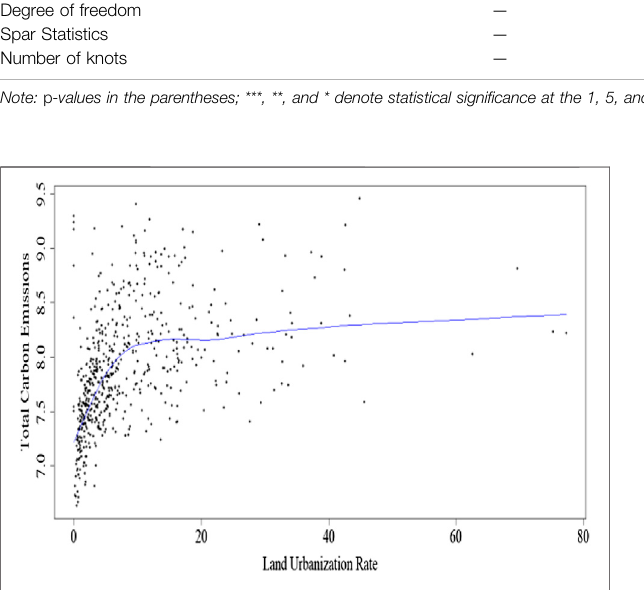
FIGURE 3 | The fi tting curve of land urbanization and total CO 2